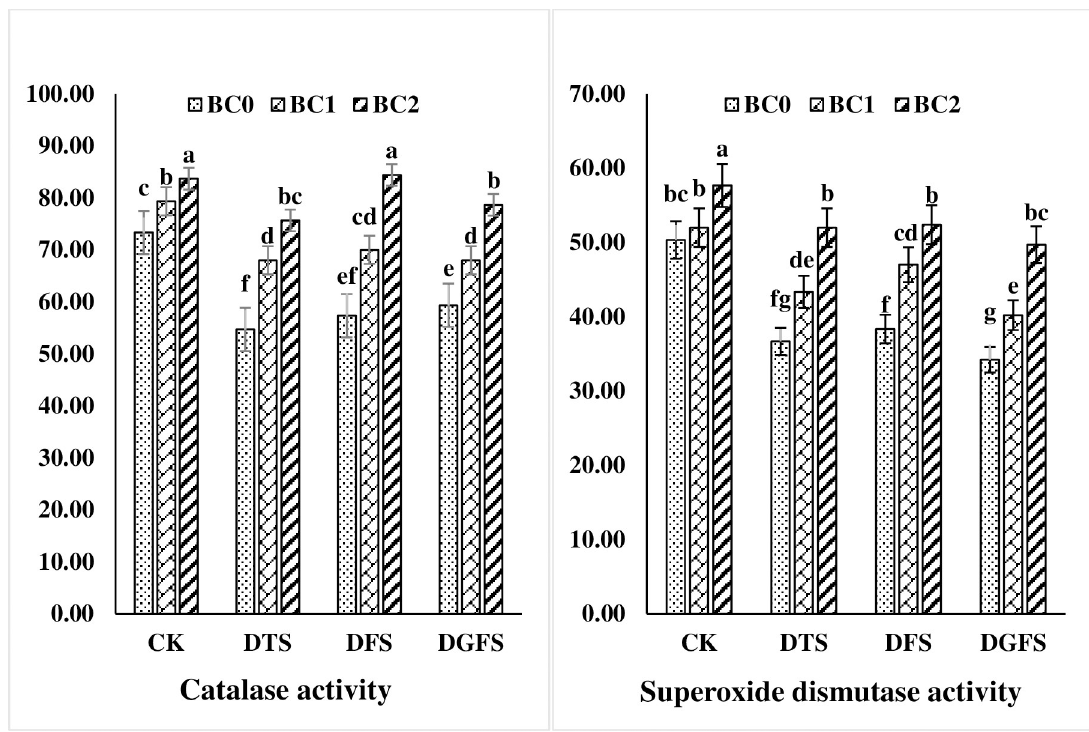
Fig 5. Catalase ( μ mol min -1 mg -1 protein) and Superoxide dismutase ( μ mol min -1 mg -1 protein) activities affected by biochar application under drought stress at critical growth stages of wheat. CK, DTS, DFS and DGFS indicates control, drought at tillering, flowering and grain filling stages respectively. BC 0 , BC 1 and BC 2 indicates control, 3% and 5% biochar respectively. Error bars indicates standard error (n = 4).